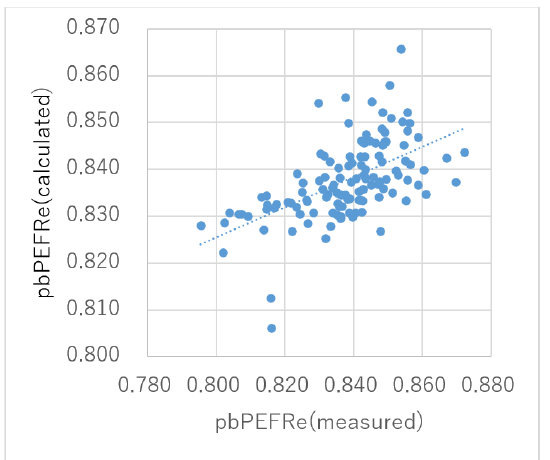
Figure 2. Correlation between calculated and measured ratio of Peak Expiratory Flow Rate to personal best peak expiratory flow rates in the evening (pbPEFRe). The relationship was statistically significant (n = 121, rs = 0.626, p = 0.000000000000017 [two tailed]). The correlation results indicated that peak expiratory flow rate depends to some extent on the concentration of ionic components.